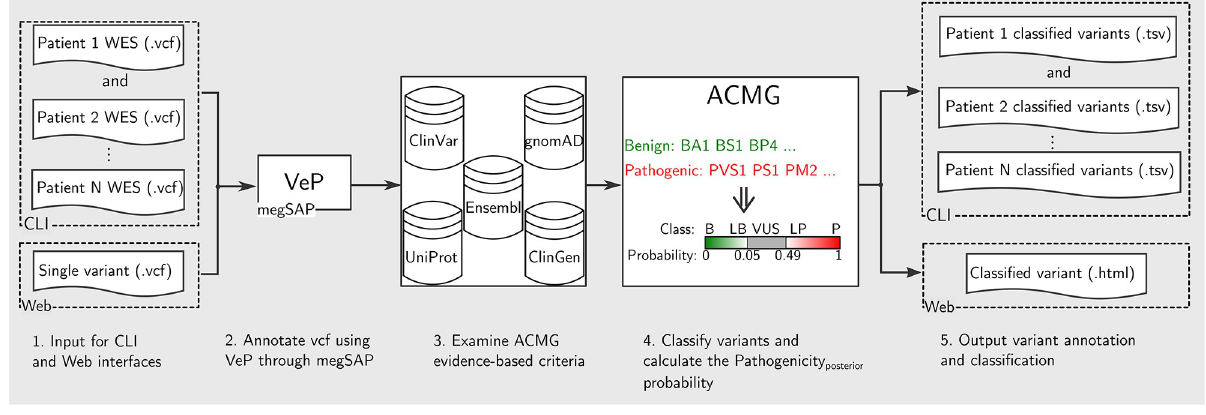
Fig 2. Conceptual workflow of